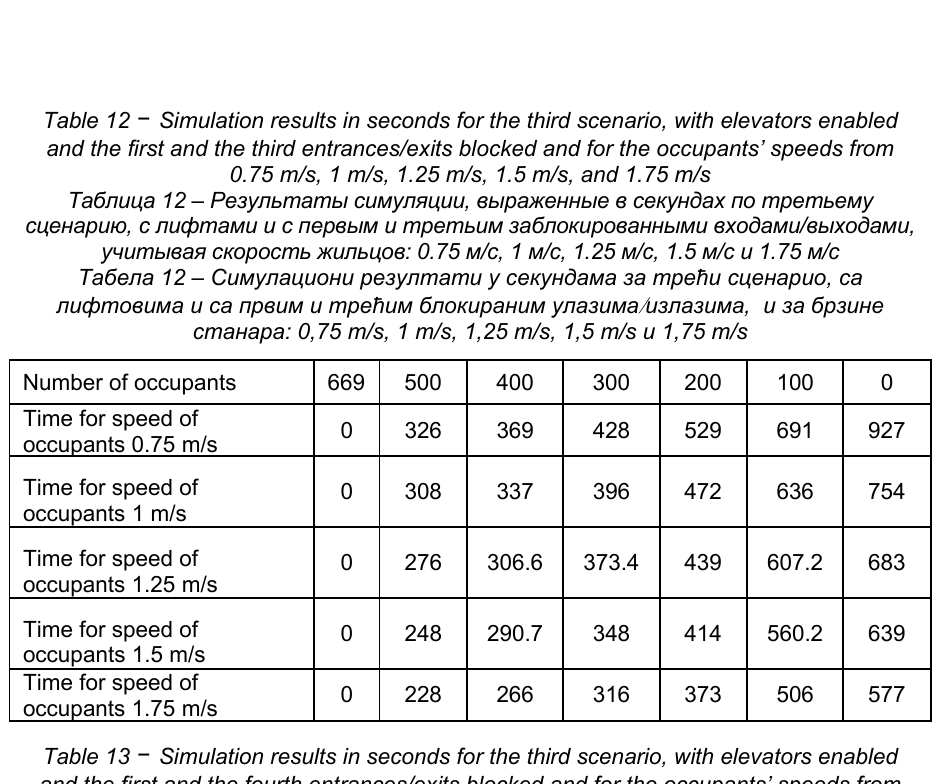
Table 12 – Simulation results in seconds for the third scenario, with elevators enabled and the first and the third entrances/exits blocked and for the occupants’ speeds from